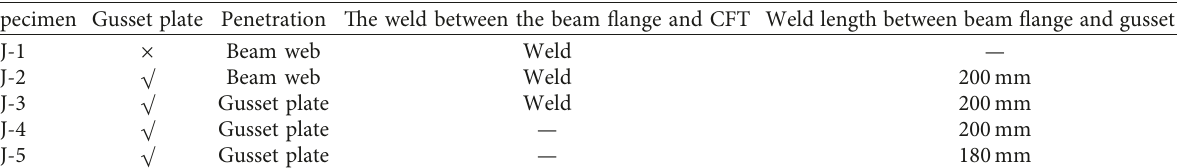
Figure 2: Connection details of the five specimens. (a) Specimen SP-1. (b) Specimen SP-2. (c) Specimen SP-3. (d) Specimen SP-4. (e) Specimen SP-5. (f) Configuration of the gusset plate. Table 1: Geometric detail of specimens.